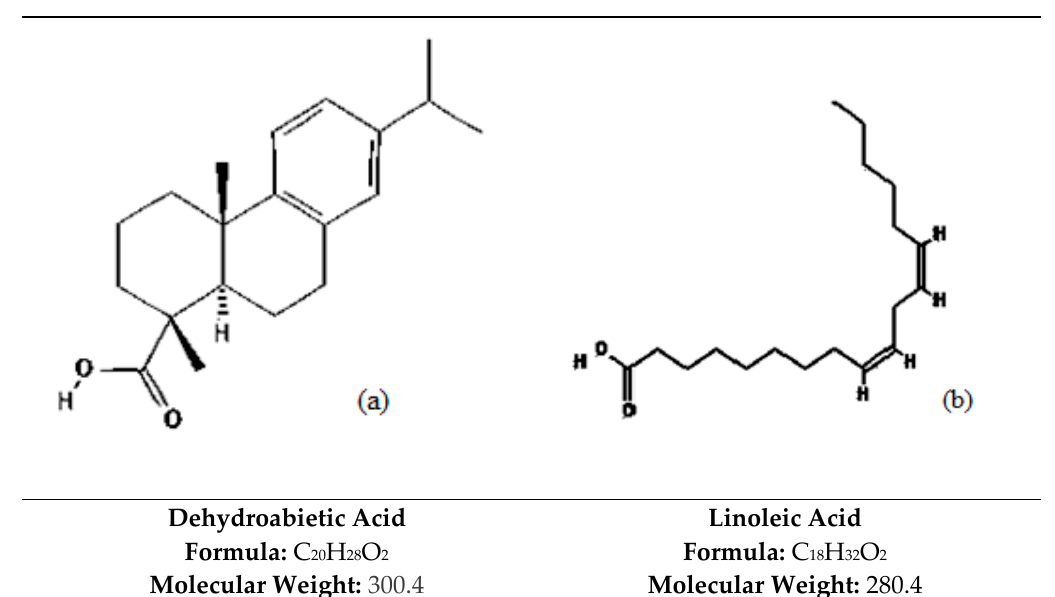
Figure 8. ( a ) Compound 1 (Dehydroabietic acid) and ( b ) Compound 2 (Linoleic acid). Compounds 1 and 2 in the most active peaks were analysed by mass spectrometry.